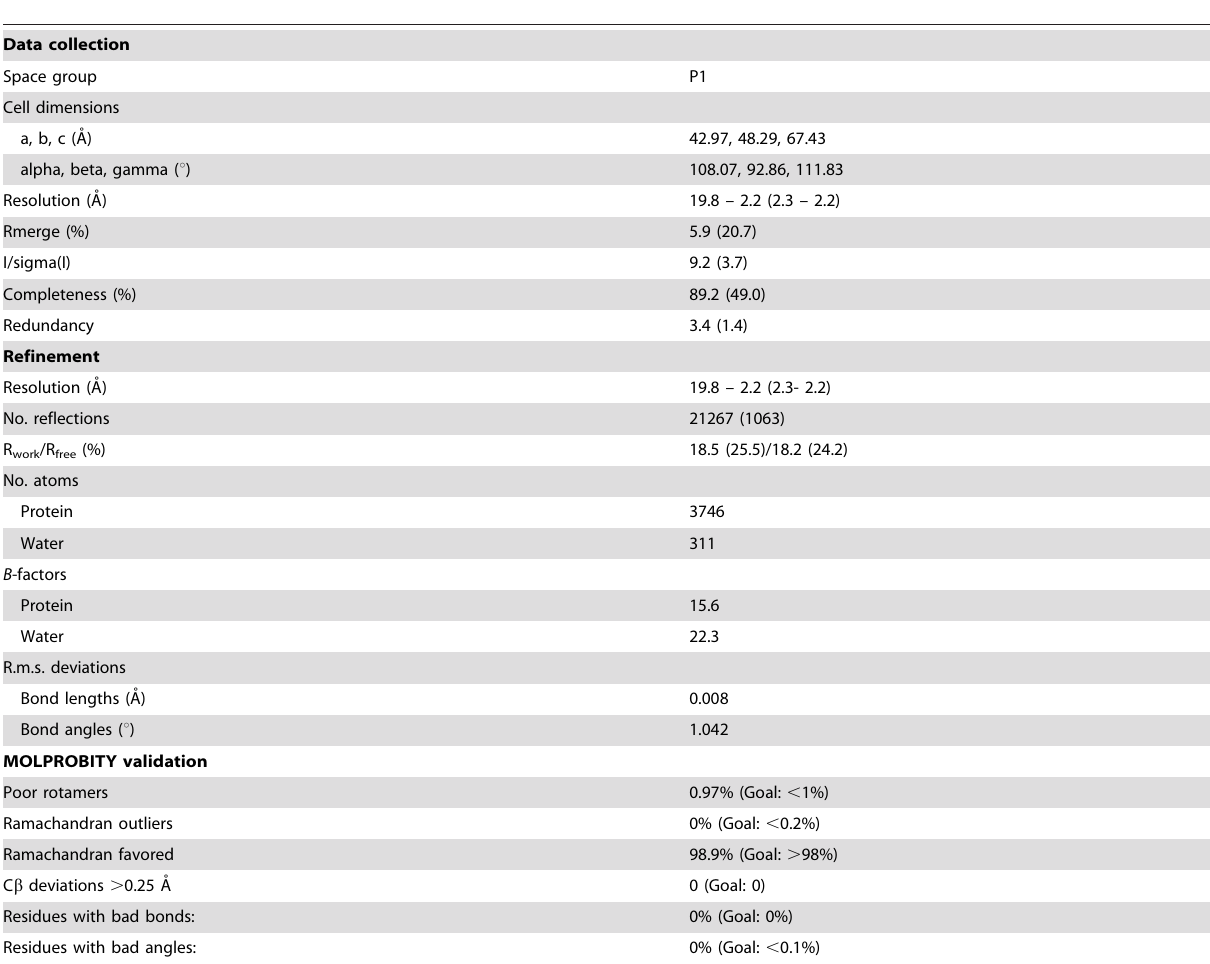
Table 1. Data Collection, Refinement and Structure Validation Statistics.